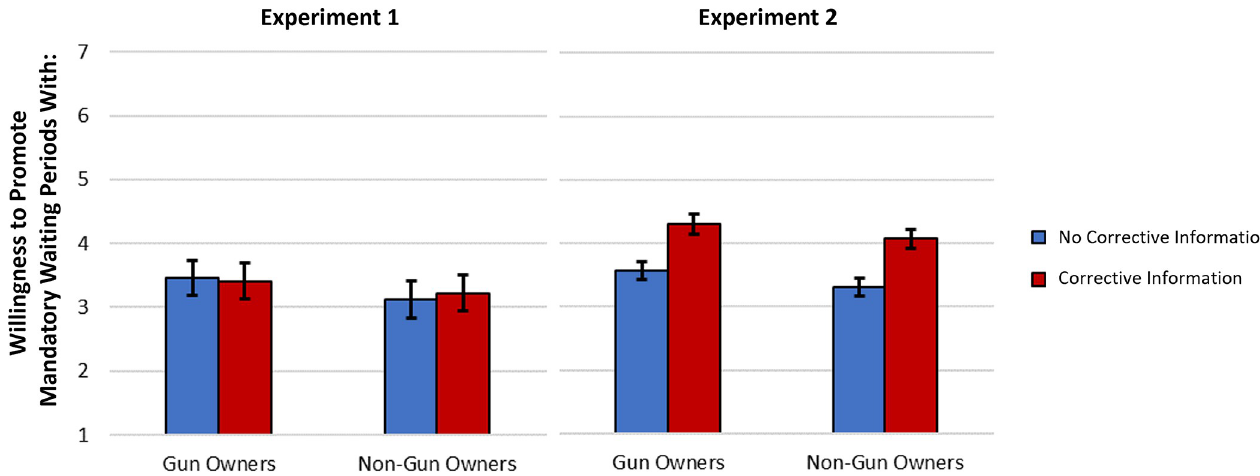
Fig 3. Willingness to promote mandatory waiting periods with gun and non-gun owners as a function corrective information condition. Data from Experiments 1 ( N = 195 gun owners) and 2 ( N = 696 gun owners). Error bars represent 95% confidence intervals.